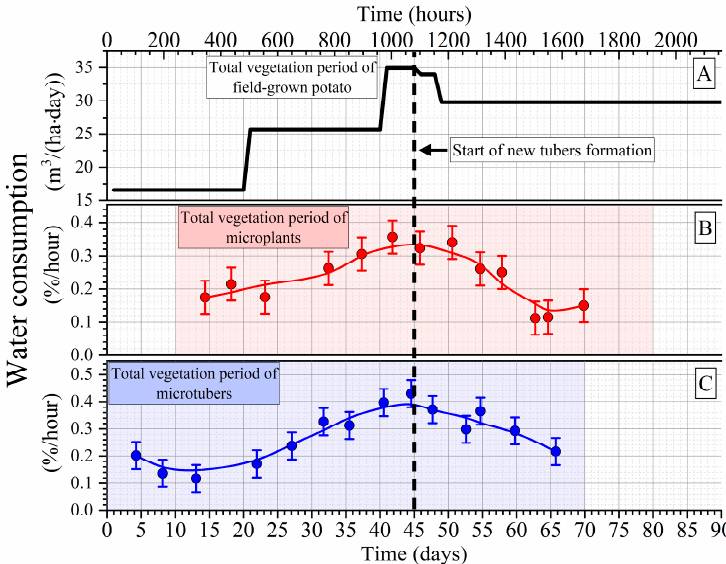
Figure 6. Dependencies of water consumption on time centered relative to the maxima, which correspond to the start of the new tubers formation process. ( A ) Water consumption of the fi eld-grown potato (data from [29]). ( B ) Water consumption of the vertical-farm-grown potato planted in the form of microplants. ( C ) Water consumption of the vertical-farm-grown potato planted in the form of minitubers. Time axis is scaled from 0 to 90 days, i.e., the total vegetative period of the fi eld-grown potato. The full vegetative period of microplants is highlighted in red, and the full vegetative period of minitubers is highlighted in blue.